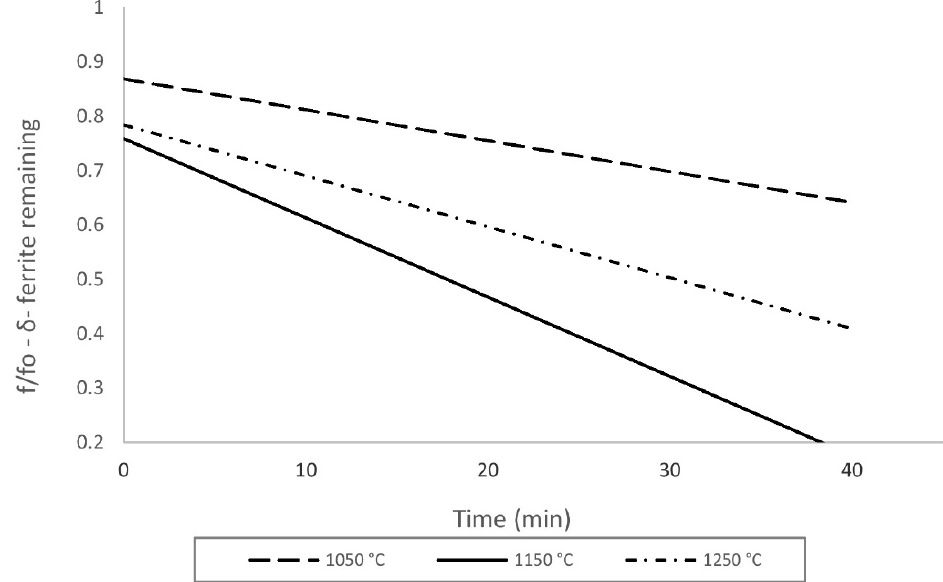
Figure 3. Comparison of the ferrite dissolution data for various heat treatments of SS2343 stainless steel.